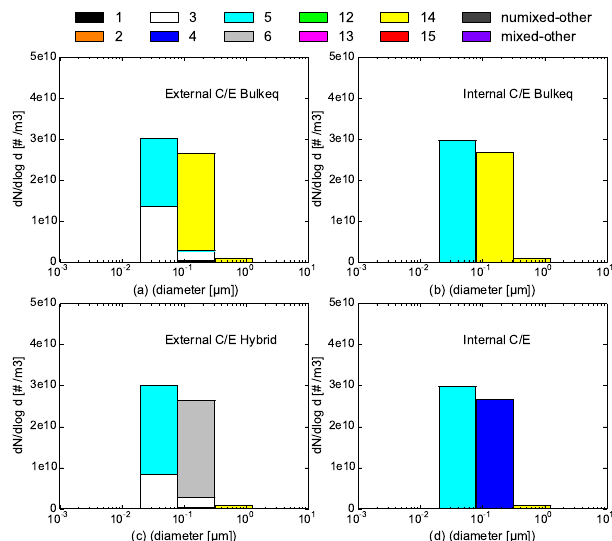
Figure 10. Result number distributions of externally mixed parti- cles as a function of particle diameter for the different chemical compositions for four different C / E simulation scenarios: (a) ex- ternal bulk equilibrium; (b) internal bulk equilibrium; (c) external hybrid method; and (d) internal